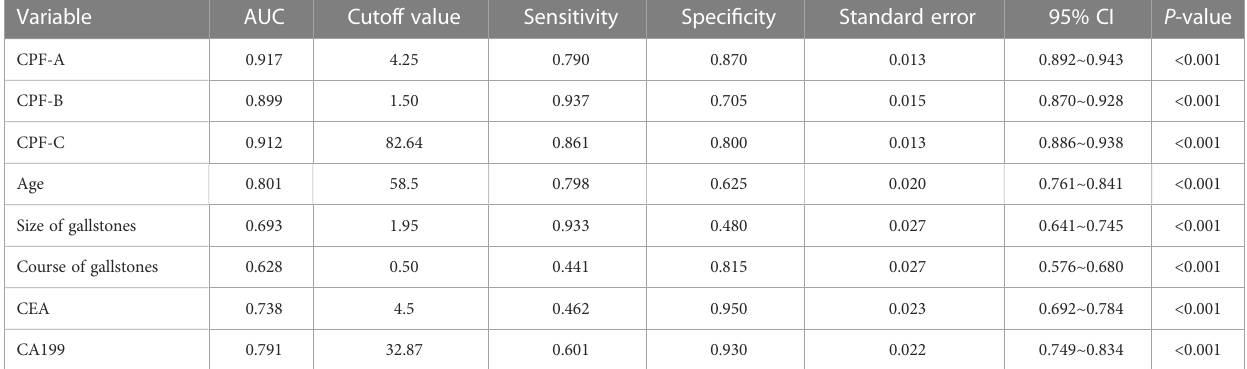
TABLE 3 Predictive values of predictive factors associated with GBC in the internal test